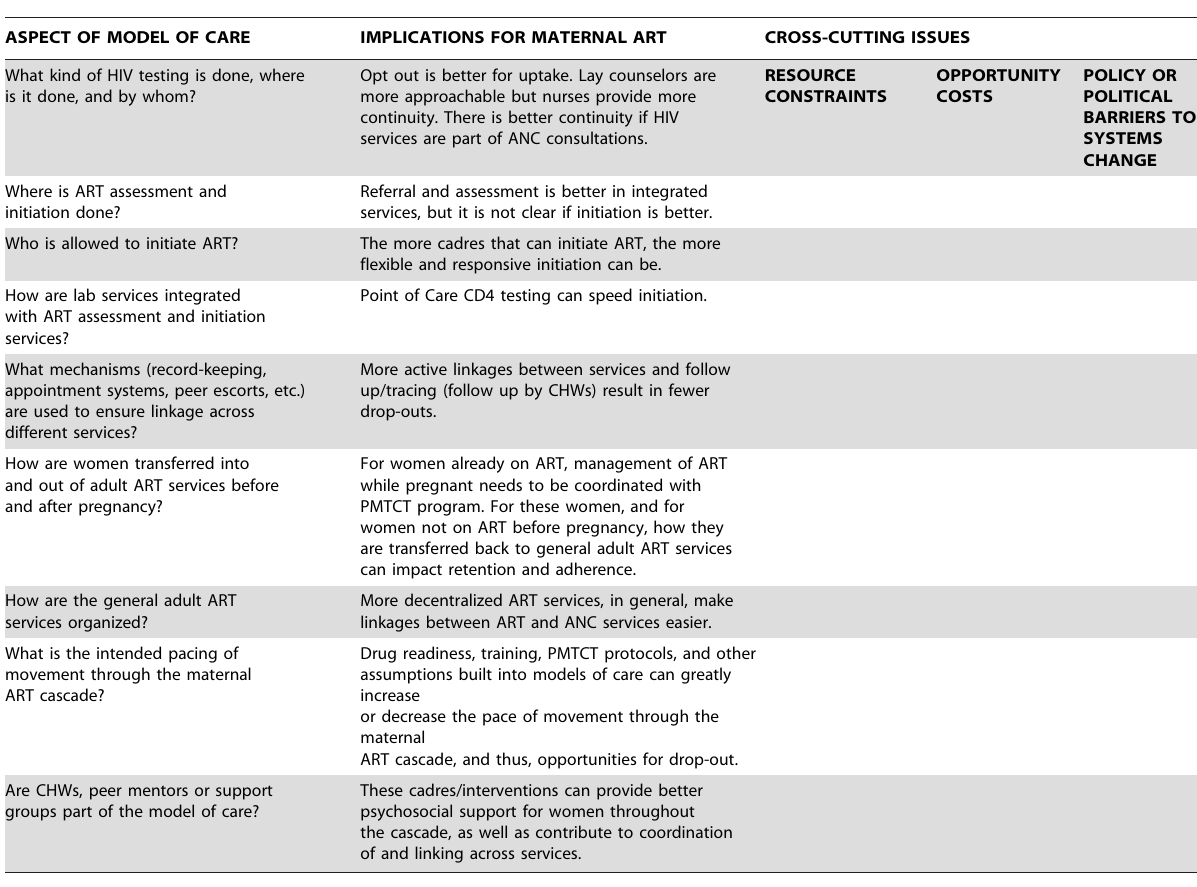
Table 4. Considerations for Maternal ART Models of